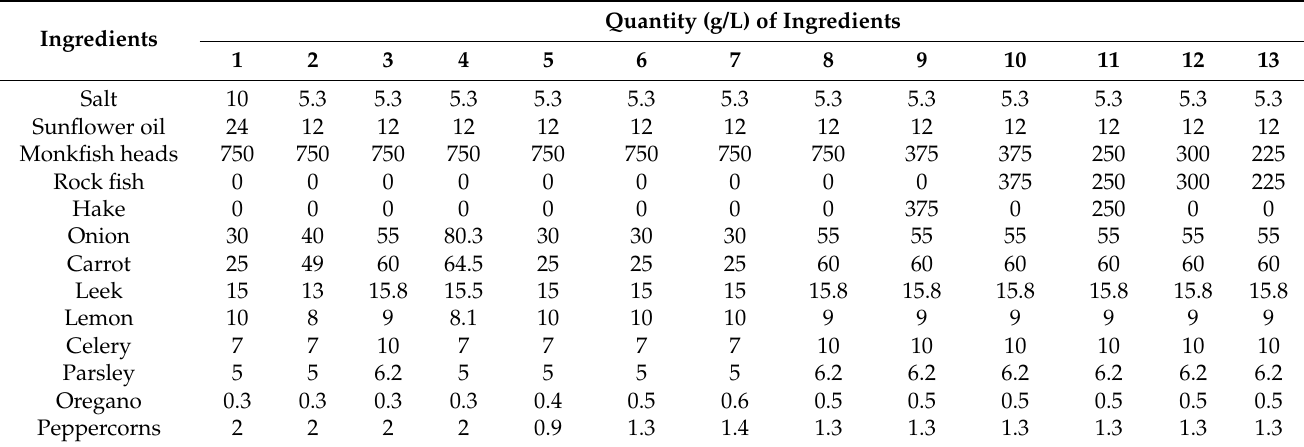
Table 1. Fish broth formulations: ingredients and